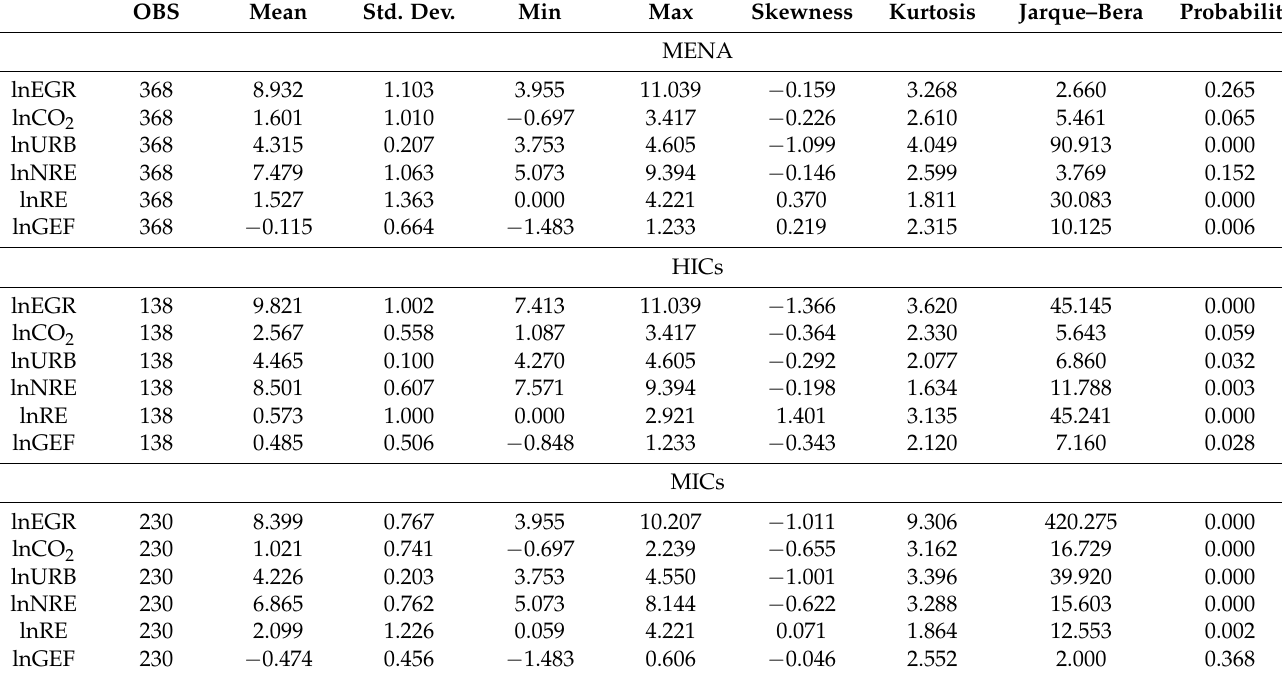
Table 3. Descriptive Statistics and Normality